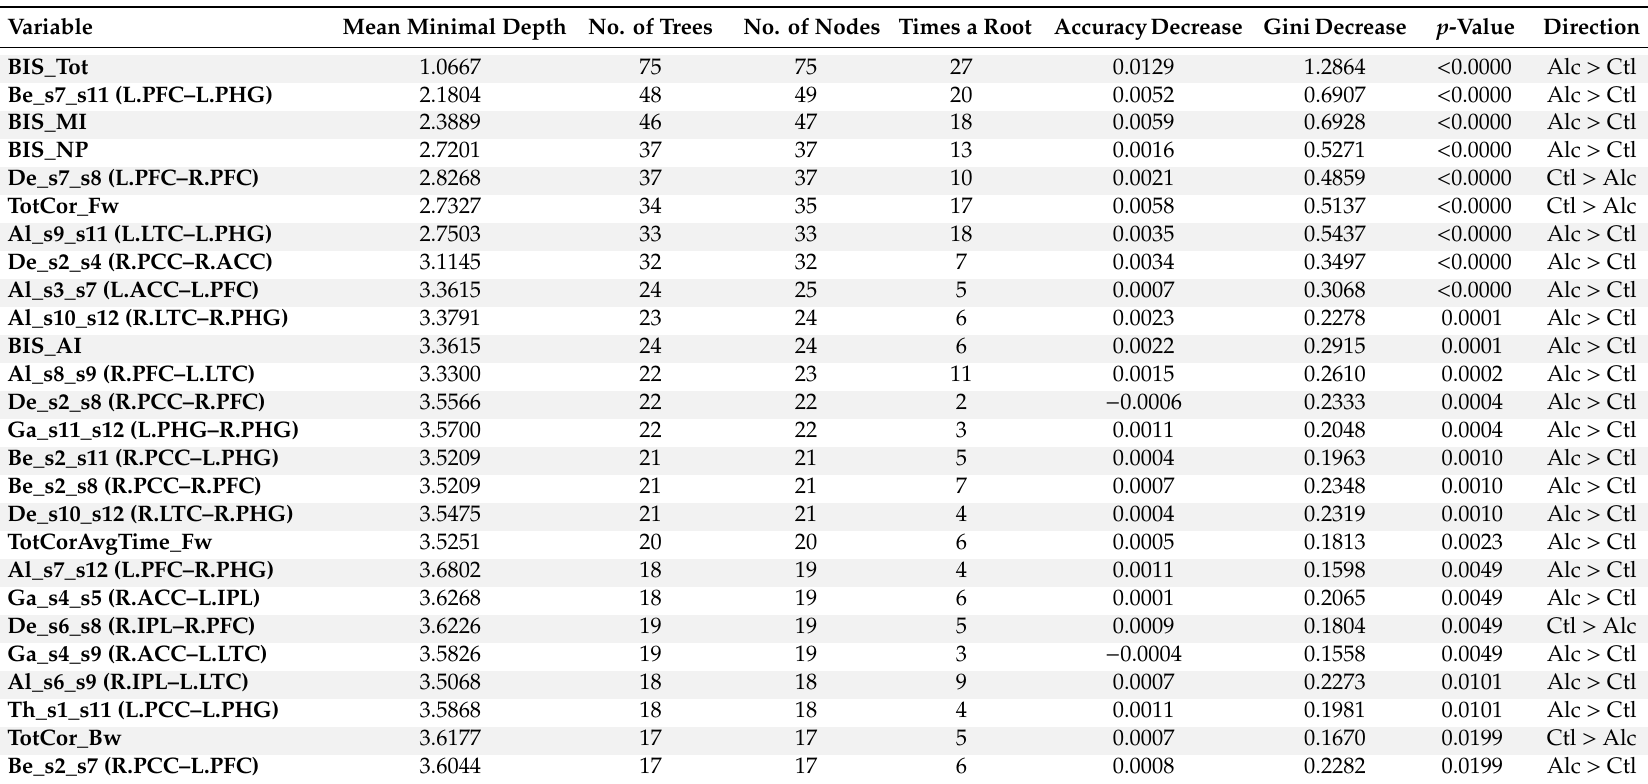
Table 3. Random Forest importance parameters (mean minimal depth, number of nodes, number of trees, times a root, accuracy decrease, Gini decrease, and p -value) and direction of significance for the top significant variables ( p < 0.05) are shown. All 4 of the impulsivity scores [total, non-planning (NP), motor (MI), and attentional (AI)], 14 FC connections, and 2 neuropsychological scores from the visual span test (span and total correct scores of the forward condition) were found to be important to classify individuals into either alcohol use disorder or control group. The variables are sorted based on p